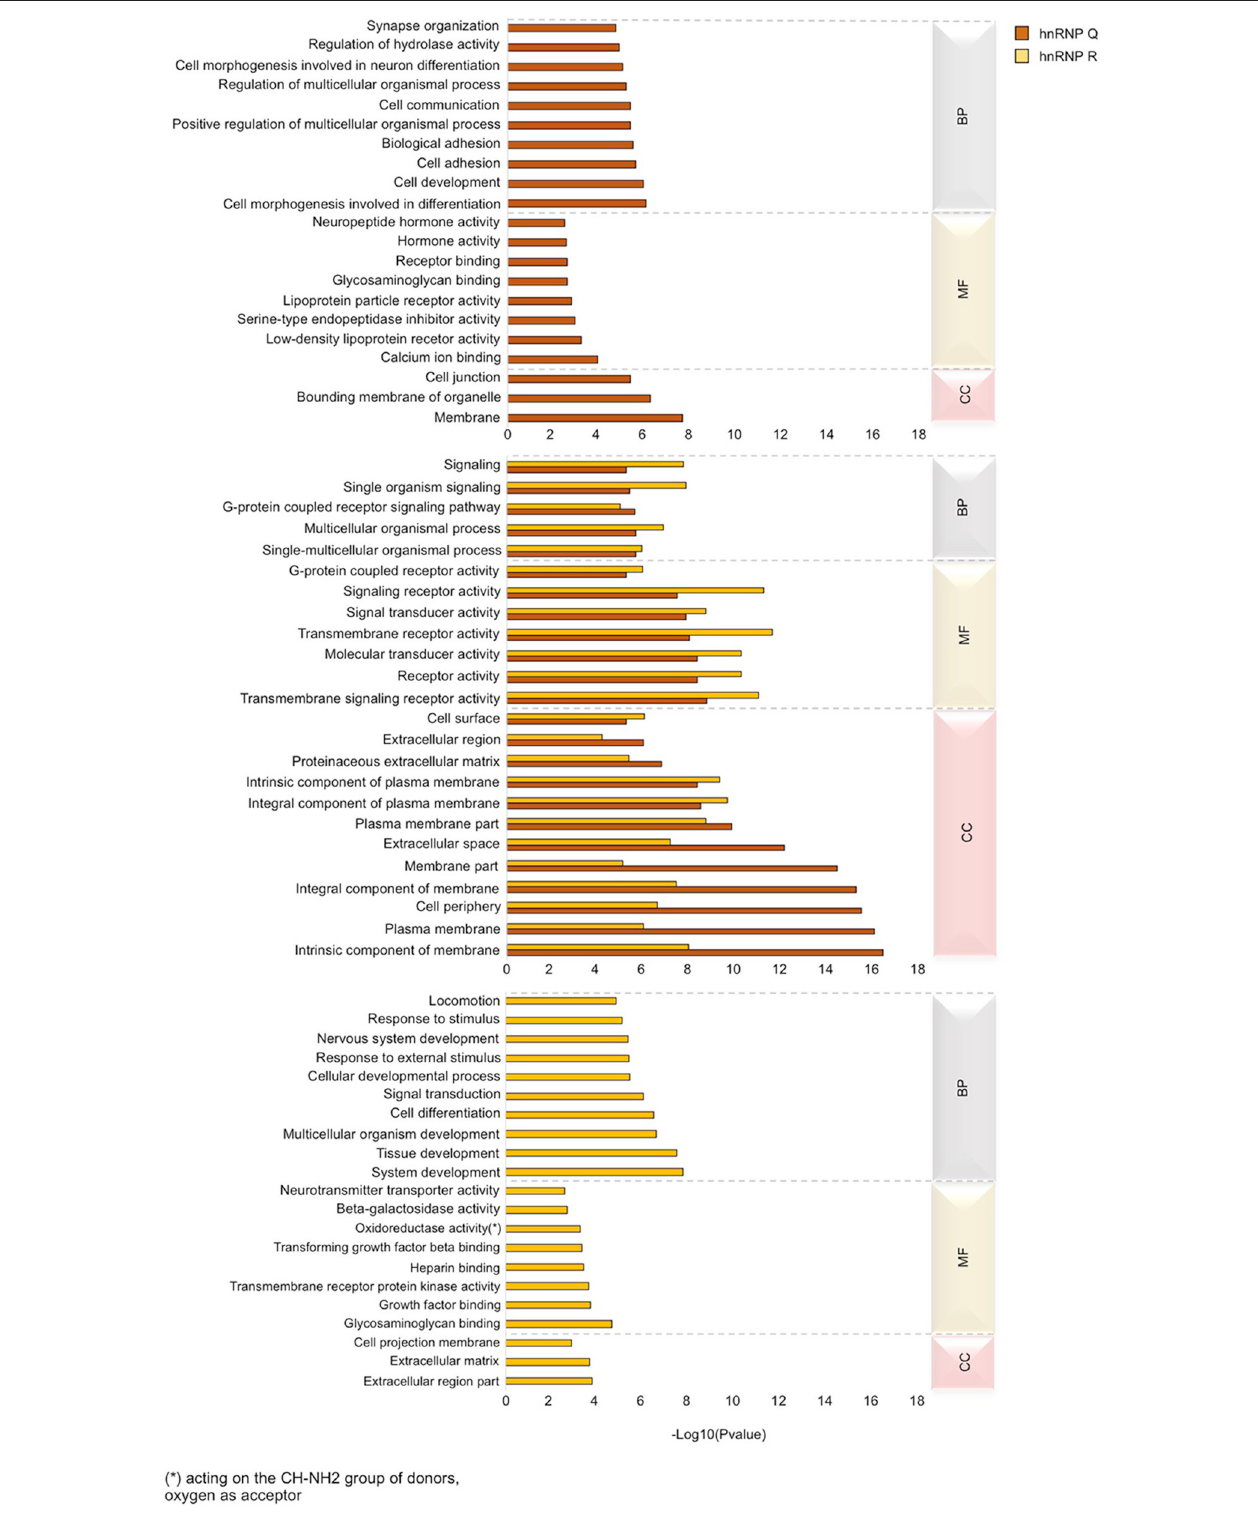
FIGURE 7 | Gene ontology (GO) analysis of DEGs in sihnRNP Q and sihnRNP R treated cells. GO enrichment analysis was performed using GOseq package Three major GO categories are highlighted: biological process (BP), molecular function (MF), and cellular component (CC). The first fifteen sub-categories ( p < 0.05) of DEGs of each category are reported for both sihnRNP Q and sihnRNP R treated